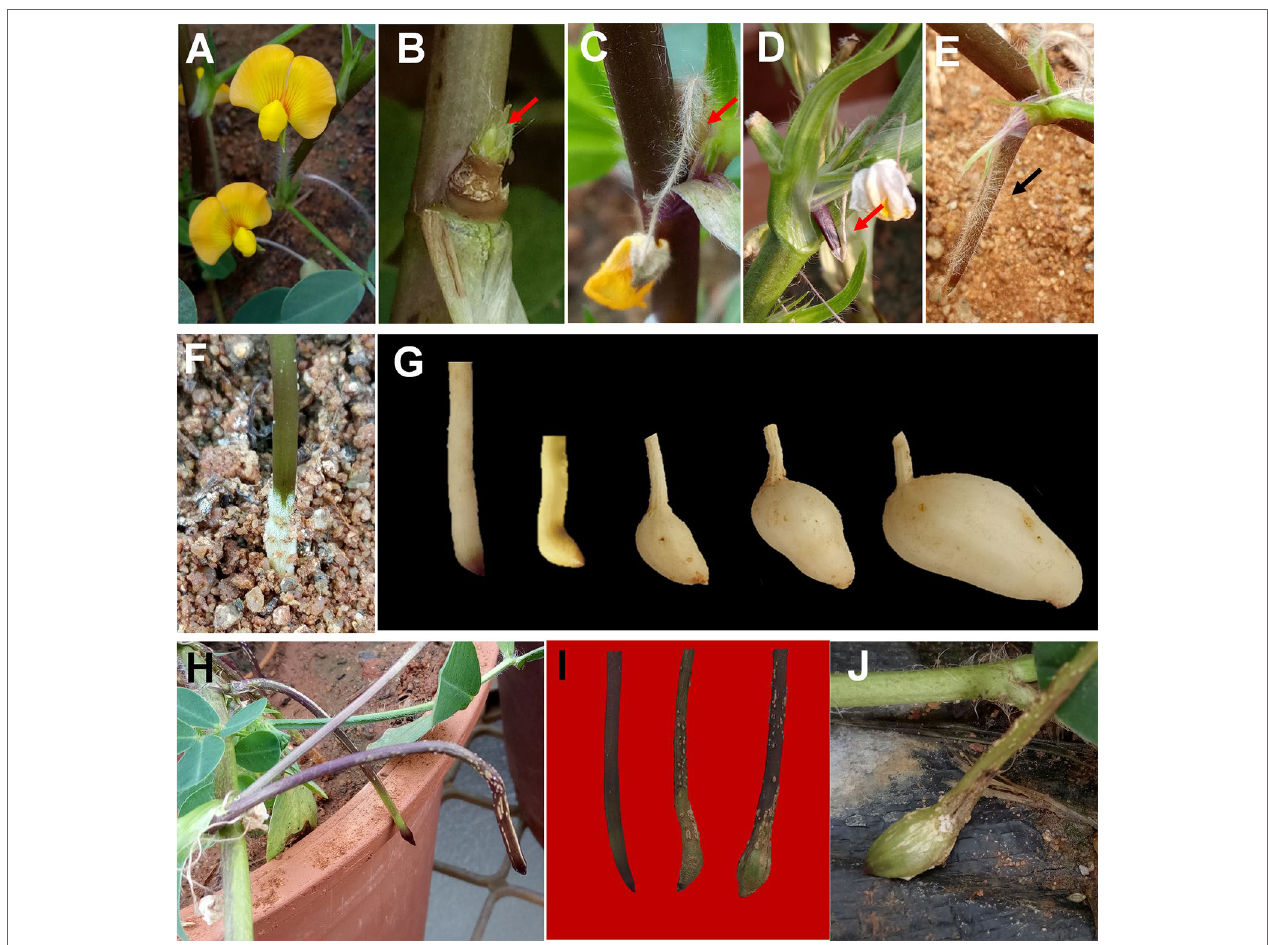
FIGURE 1 | Peg development and formation of aerial pod in peanut. (A) flower; (B) emasculated flower ovary at the base of gynophore; (C) emergence of peg from dehisced flower; (D – E) , peg bending towards gravity; (F) peg penetration into the soil with whitish hairs at the base of soil penetration; (G) morphological changes into a peg after soil penetration; (H) abortion of aerial peg due to failure of soil penetration; (I – J) development of aerial pod under water deficit condition. Arrow is used to highlight the specified content of respective